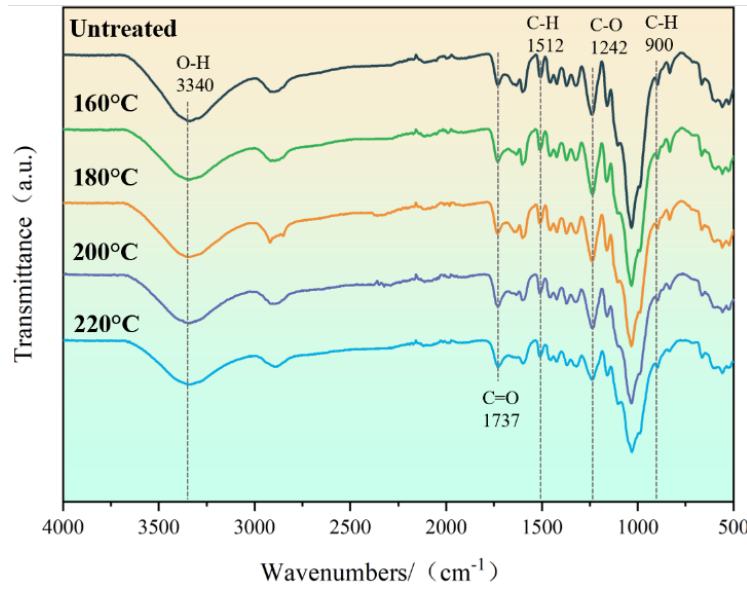
Figure 5. FTIR analysis of untreated and heat-treated specimens.